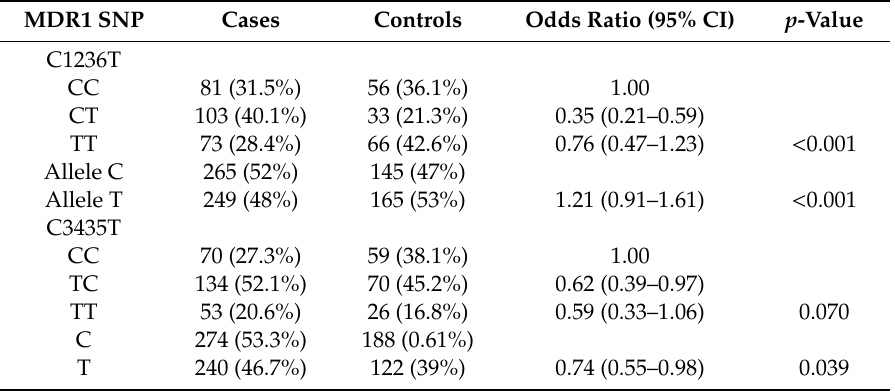
Table 2. Association between SNPs and H. pylori infection as calculated using SNPStats.